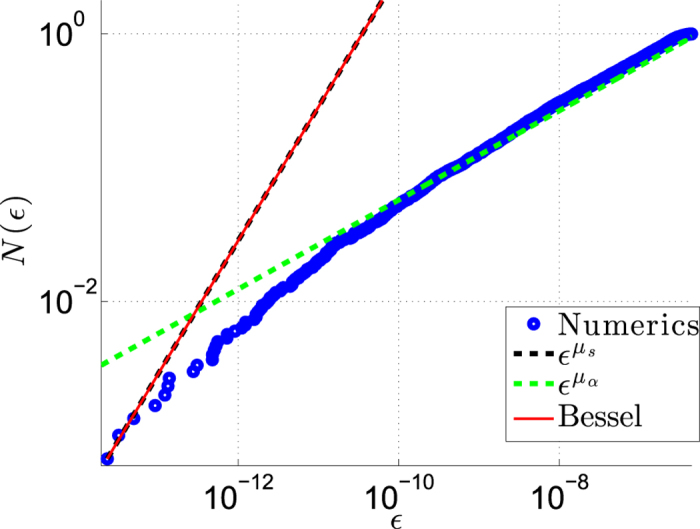
The spectrum of the associated hermitian matrix.We calculate numerically the integrated density, which counts the eigenvalues {k < } of H for a ring with N = 3000 sites. The system is characterized by a percolation exponent μ = μα = 1/3, and by a scaled affinity μ = μs = 1. The stochastic-field distribution is with σ = 2. The blue points are results of numerical diagonalization. There is a crossover from density that corresponds to μs (dashed black line), to density that corresponds to μα (dashed green line). The red line is the Bessel expression of6.